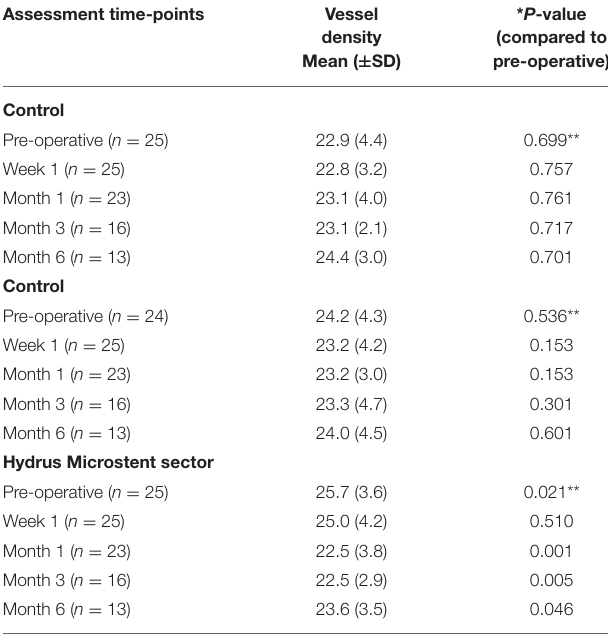
TABLE 1 | Optical coherence tomography angiography vessel density measurements of episcleral vasculature in sectors with Hydrus Microstent implants and controls comparing pre-operative and post-operative week 1 and month 1, 3, and 6. Assessment time-points